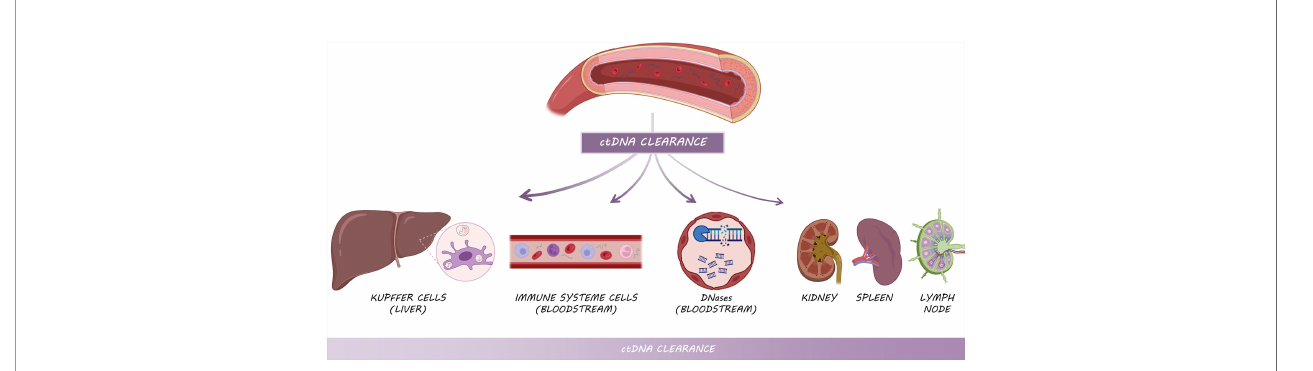
FIGURE 4 | Mechanisms of ctDNA clearance: Kupffer cells from the liver are primarily responsible for ctDNA clearance, followed by circulating enzymes and immune system cells and other fi ltering organs such as kidneys, spleen and lymph nodes.